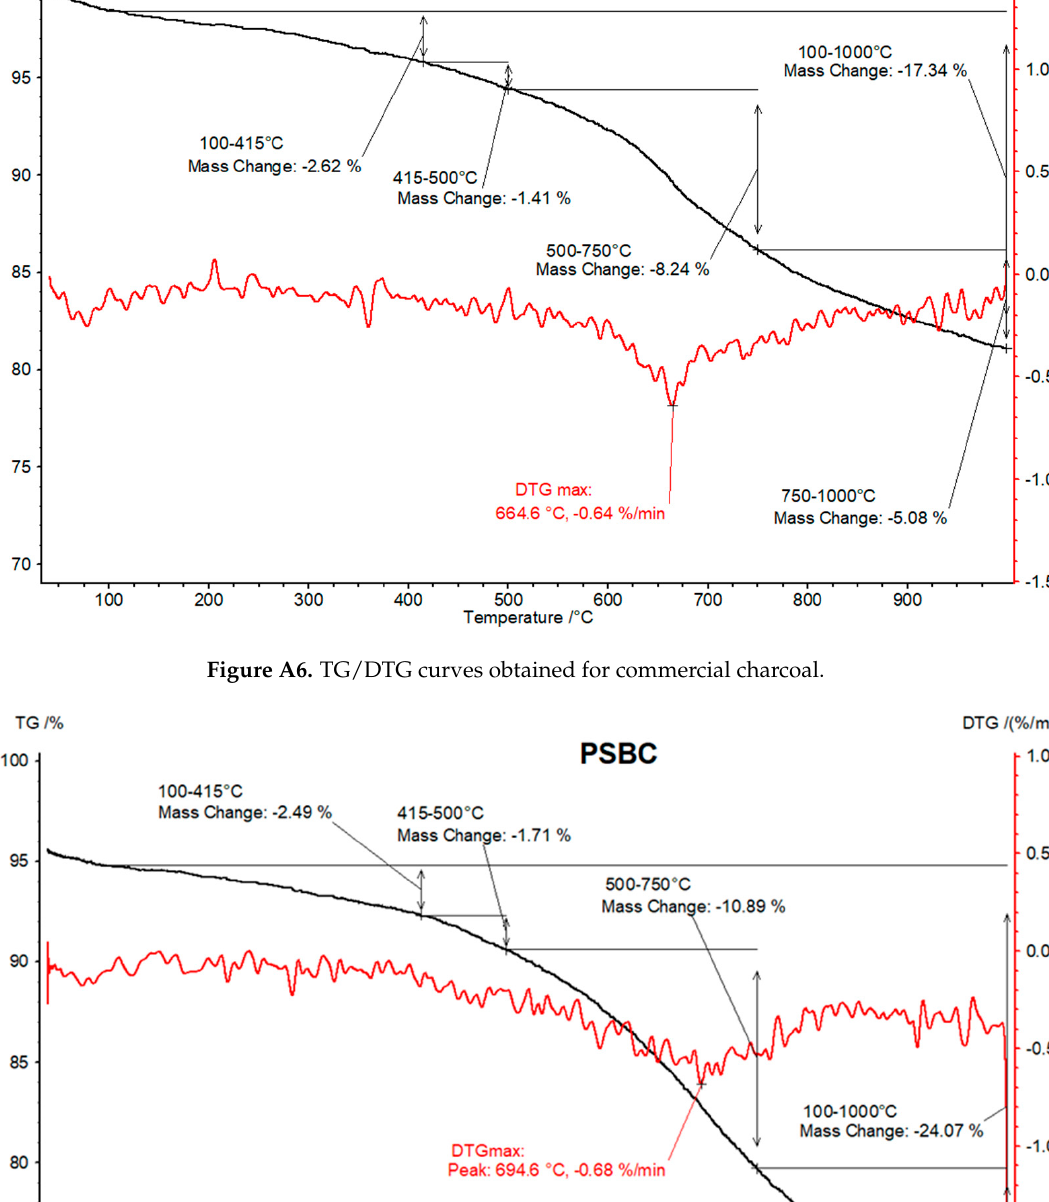
Figure A5. TG/DTG curves obtained for hazelnut shells.